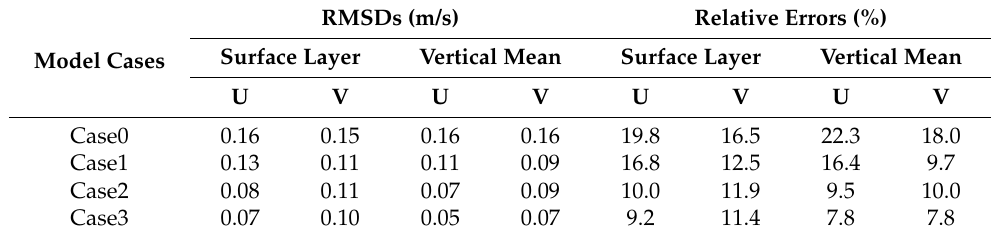
Table 3. Model accuracy at